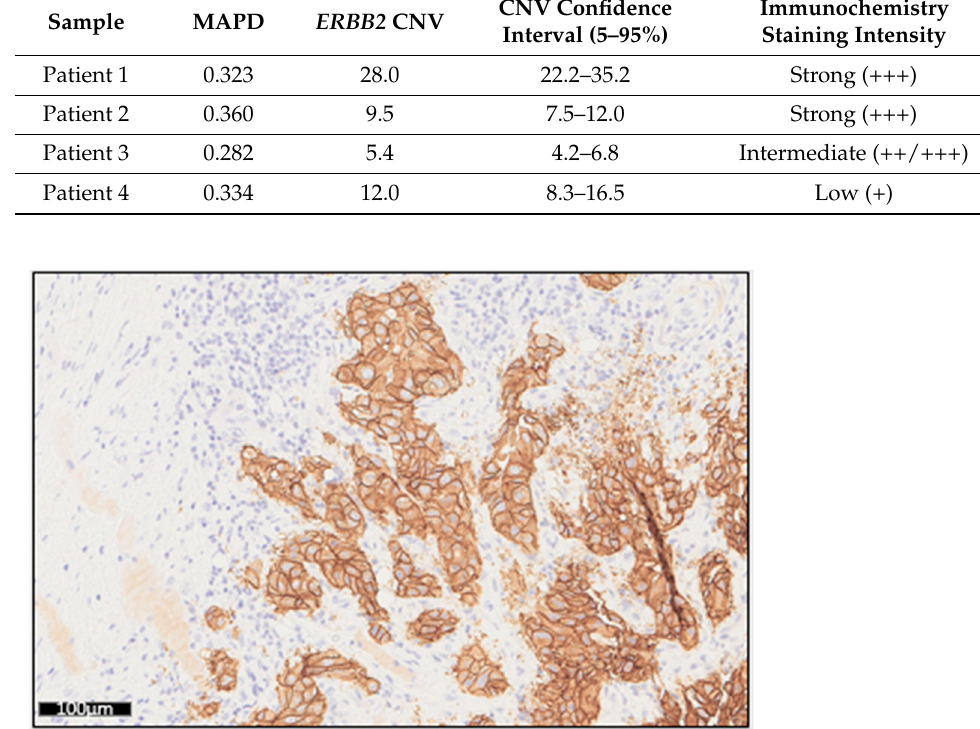
Table 3. ERBB2 gene amplification evaluation by NGS and immunochemistry analysis.